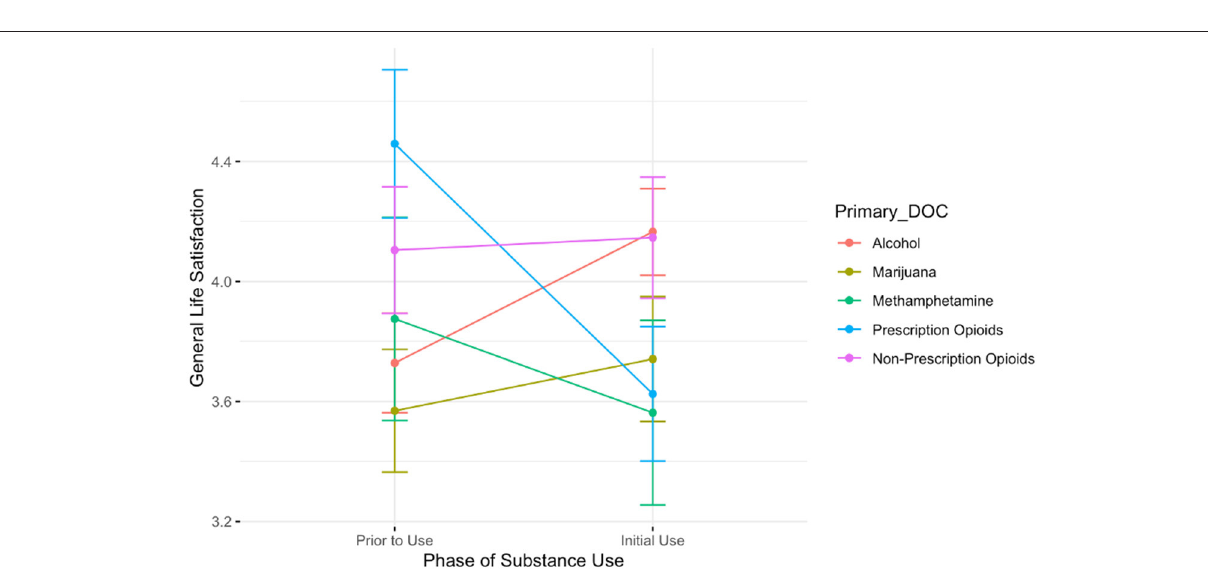
FIGURE 5 | A plot showing the average general life satisfaction scores for participants prior to the onset of substance use and during the initial stages of use. Lines are colored by participant primary substance of choice. The group showing the steepest decrease in general life satisfaction between these two timepoints is those who reported using prescription